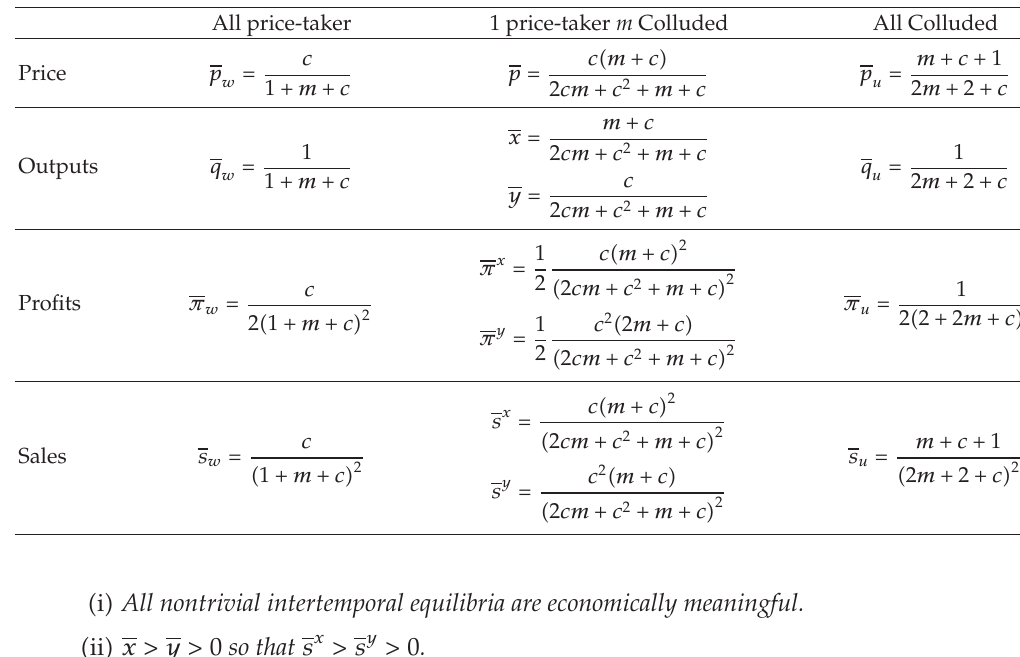
Table 1: Equilibrium